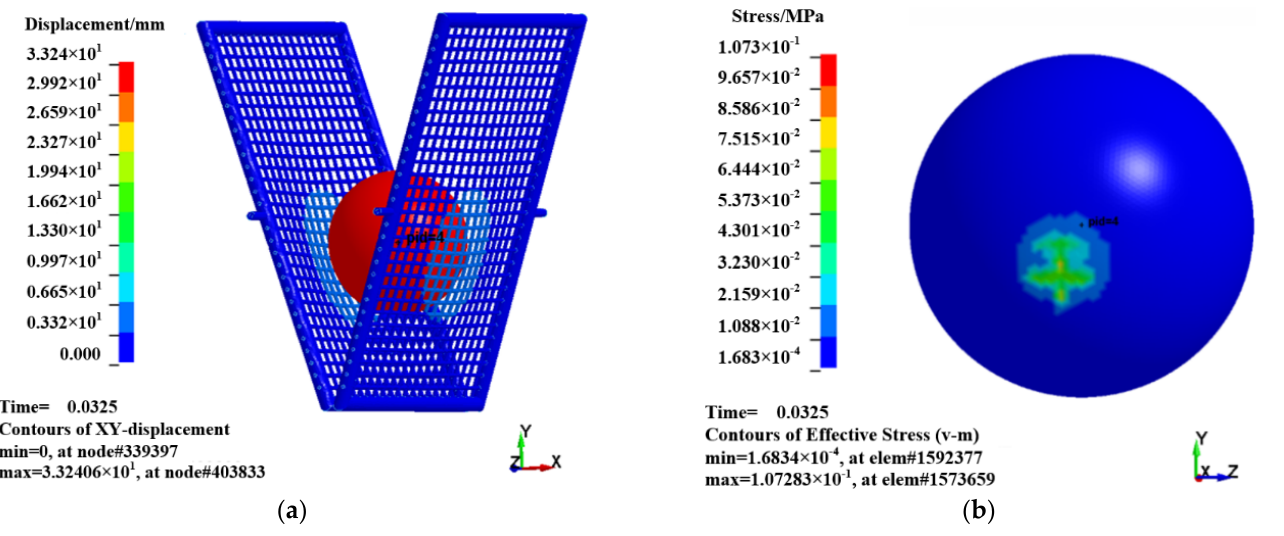
Figure 9. Simulation results of tomato drop in condition 1. ( a ) The falling displacement of the tomato ( b ) The maximum stress on the tomato.